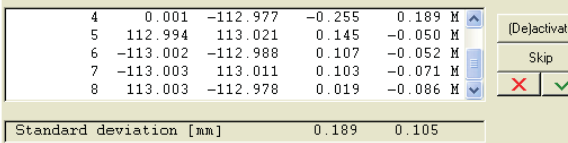
Fig. 5. A fragment of results taken from the inner orientation of the photographic image